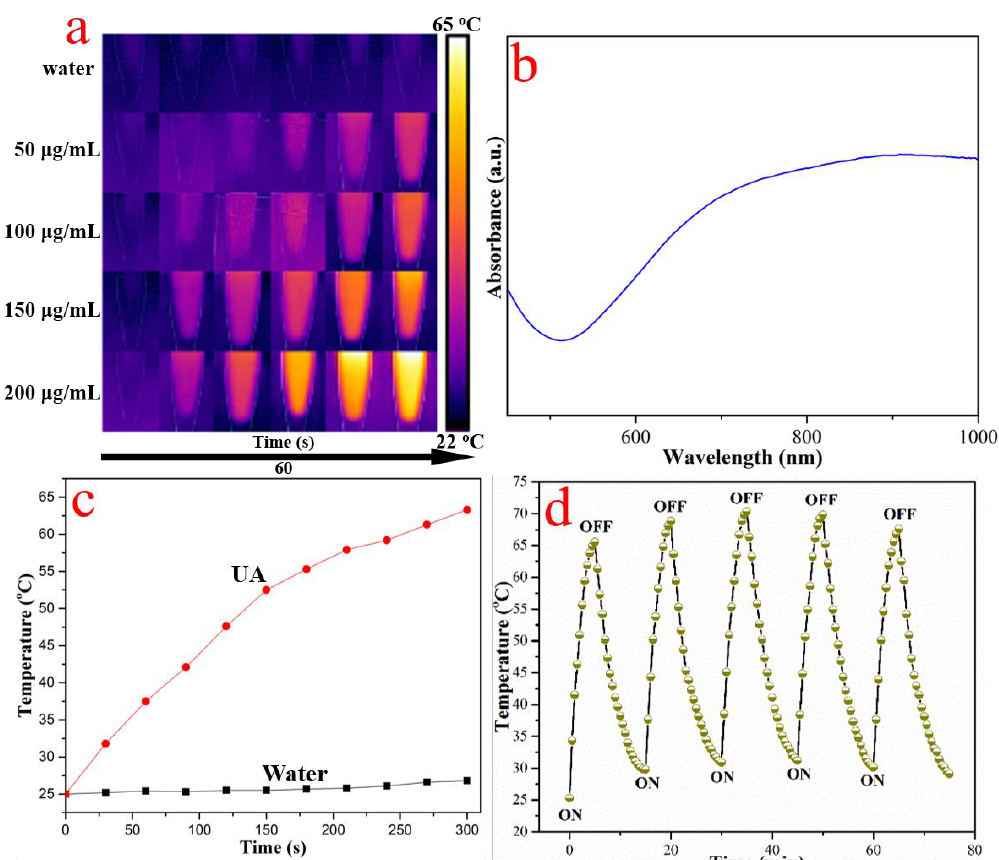
Figure 3. ( a ) Thermal images of PBS and different concentrations of UA under NIR laser irradiation. ( b ) UV-vis spectra of UA. ( c ) Temperature curve of water and of UA under NIR irradiation (100 μg mL −1 , 1.0 W cm −2 ). ( d ) The temperature variation of UA-BNN6 aqueous solution over five on/off cycles upon 808 nm NIR laser irradiation (100 μg mL − 1 , 1.0 W cm −2 ).